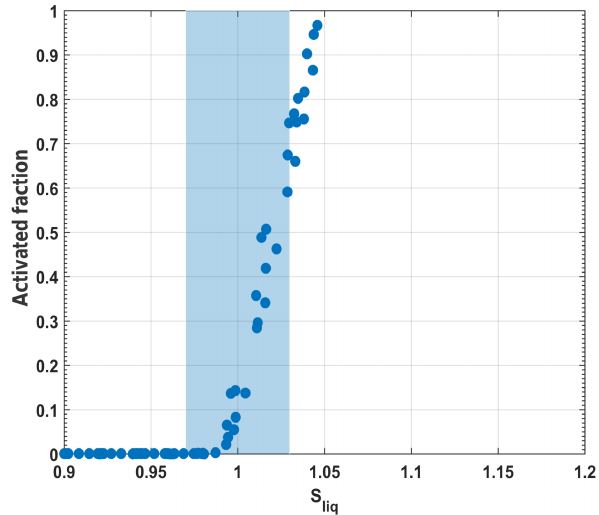
Figure 9. Fraction of 400nm (dry diameter) NH 4 NO 3 particles freezing homogenously as a function of S liq in ZINC at − 40 ◦ C. For these conditions particles should freeze at S liq ∼ 0.99 (Koop et al., 2000). Shaded region indicates the range and uncertainty of S liq that the aerosol in the lamina are exposed